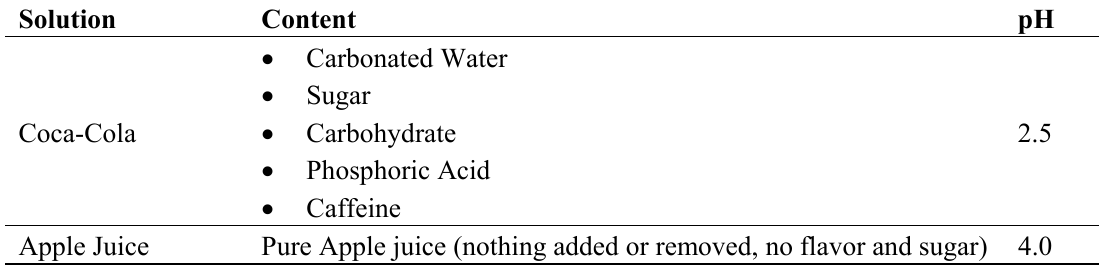
Table 2. Solvent used in the study along with contents and pH